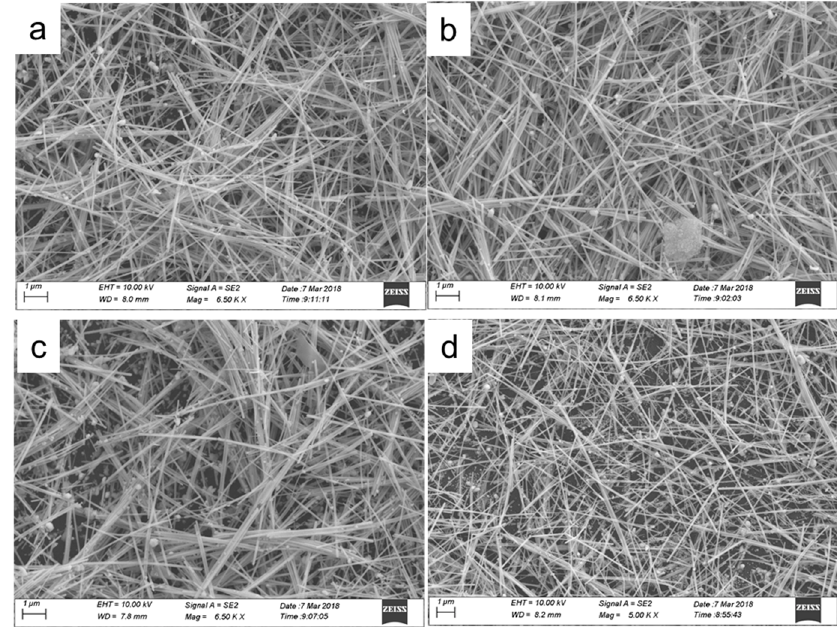
Figure 9. SEM images of coating with the different concentrations of AgNWs, ( a ) 10.8, ( b ) 8.70, ( c ) 4.30, ( d ) 2.61 mol·L − 1 , respectively.